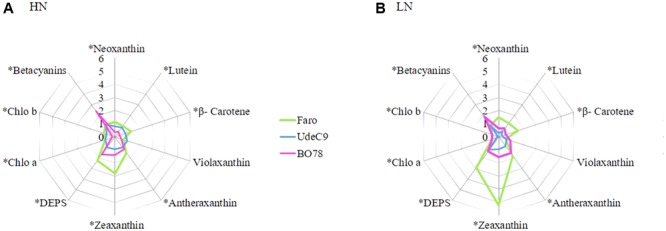
Effect of water stress during senescence on carotenoids, chlorophylls, and betalains in three genotypes of quinoa grown at two levels of nitrogen supplementation. Radar charts showing changes in the relative contents of pigments in three genotypes of Chenopodium quinoa grown at HN (A) and LN (B) subjected by 15 days to water stress respect to control plants. Relative contents were calculated as the ratio of the relative content for each pigment to their control sample. Values are means of n = 4. Asterisks indicate significant differences among genotypes (p < 0.05) using a one-way ANOVA.